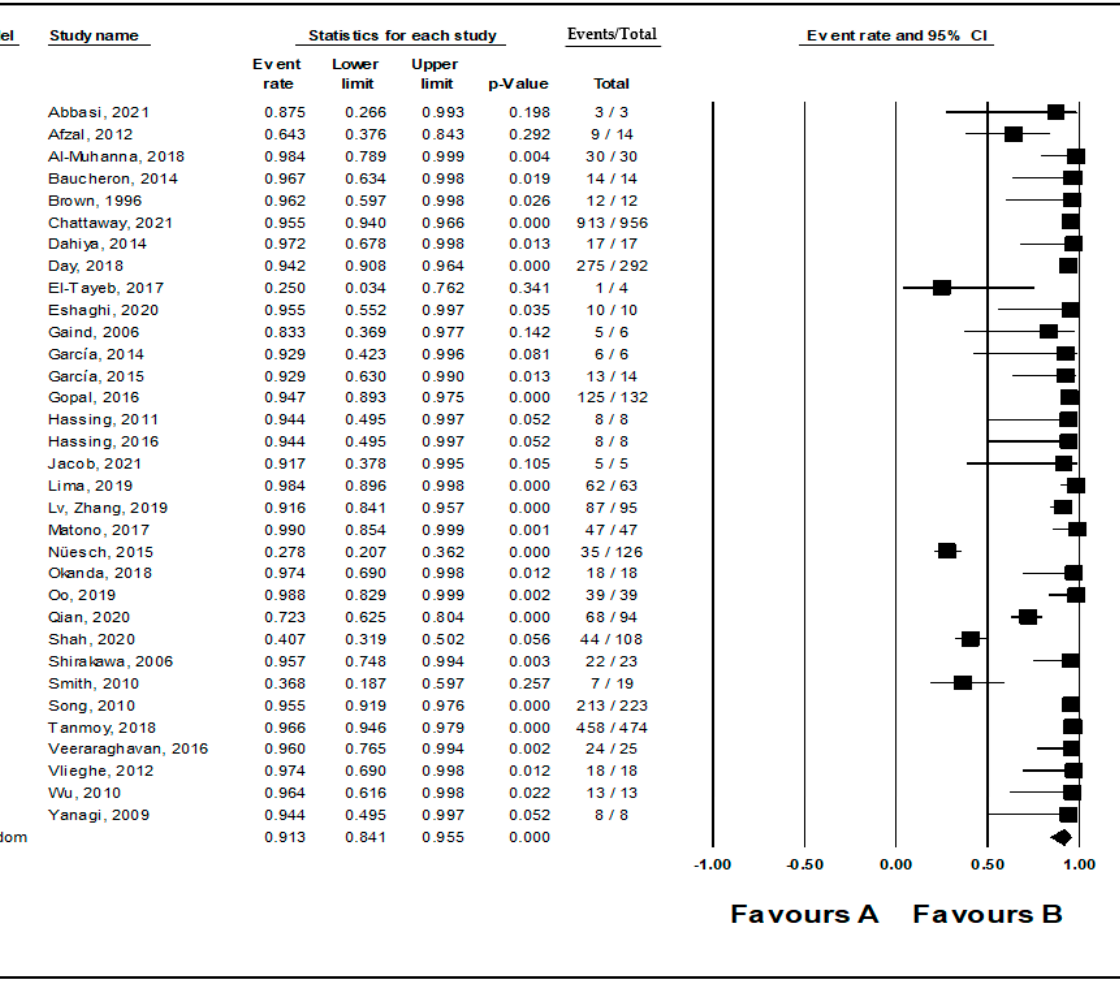
Figure 5. Forest plot showing the pooled prevalence of gyrA gene in resistant S. Typhi isolates estimated by a random effect model of meta-analysis. (91.3%, I 2 : 93.99, 95% CI: 84.1–95.5, p -value < 0.001) [12–53].